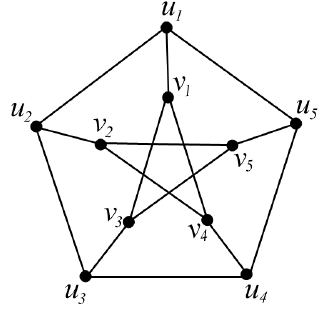
Figure 1. The Petersen graph P .